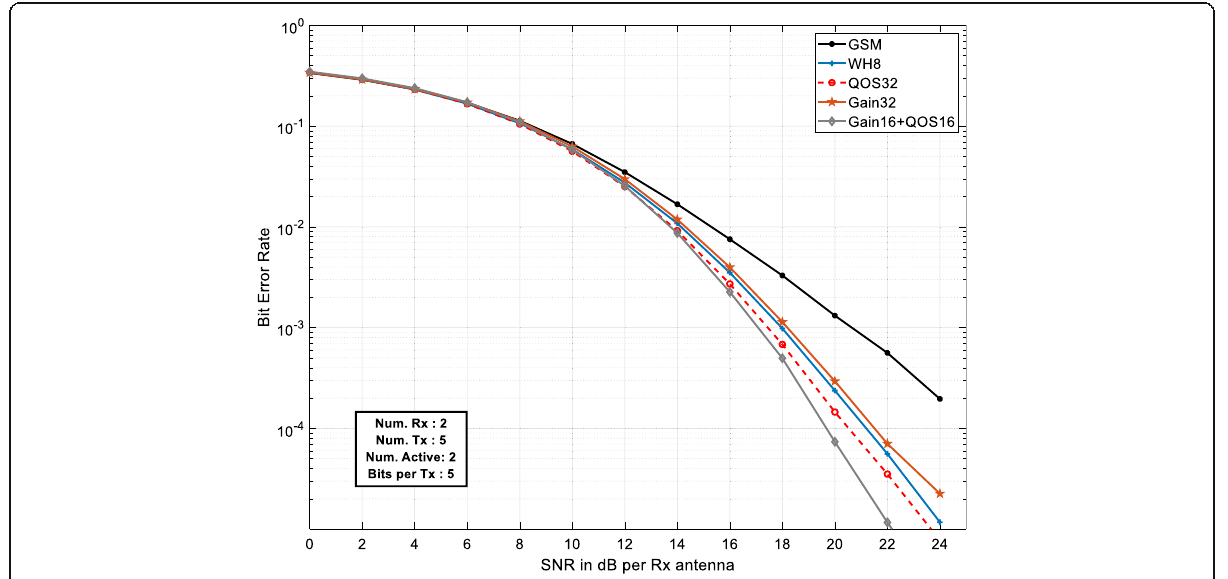
Fig. 5 BER performance of GSM-CP system with codebook precoding and fixed TAC-set at N t = 5, N a = 2, and N r = 2